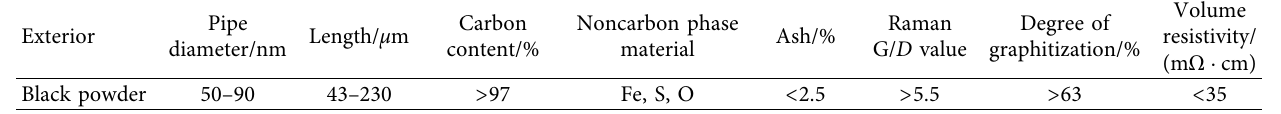
Table 1: Main performance parameters of carbon nanotubes.